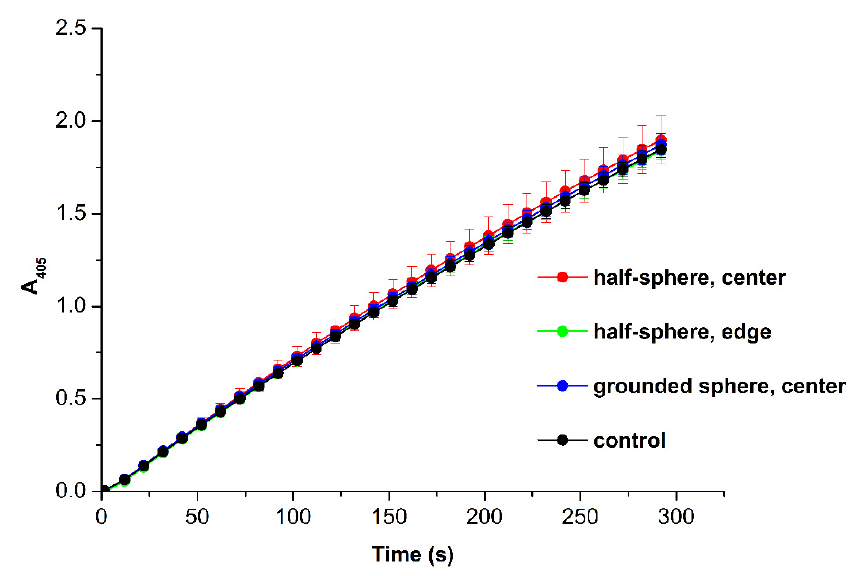
Figure 5. Results of spectrophotometry-based estimation of HRP enzymatic activity using a standard assay with ABTS. Typical time dependencies of the absorbance at 405 nm obtained for the HRP solutions incubated in the center of the half-sphere (red), near the edge of the half-sphere (green), in the center of the grounded sphere (green), and 2 m away from the half-sphere (control solution; black). Experimental conditions: HRP:ABTS:H 2 O 2 = 10 − 9 M:0.3 mM:2.5 mM. T = 23 °C.